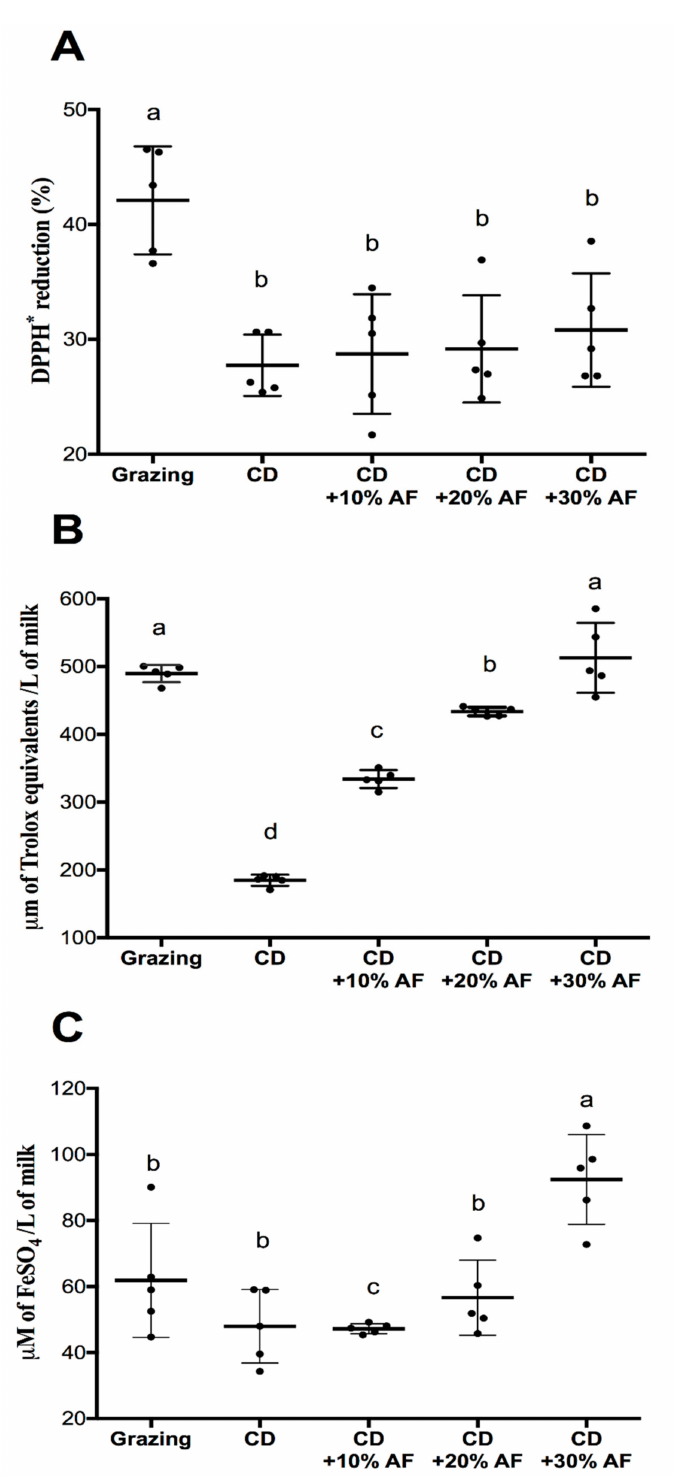
Figure 3. Total antioxidant activity of milk extracts from goat’s fed under grazing system, conventional diet (CD), or CD supplemented with di ff erent levels of Acacia farnesiana pods (AF). DPPH • scavenging capacity ( A ). Oxygen radical absorbance capacity (ORAC) assay ( B ) and ferric-reducing antioxidant power (FRAP) assay ( C ). a,b,c,d Means with di ff erent letters indicate di ff erences ( p < 0.05) among